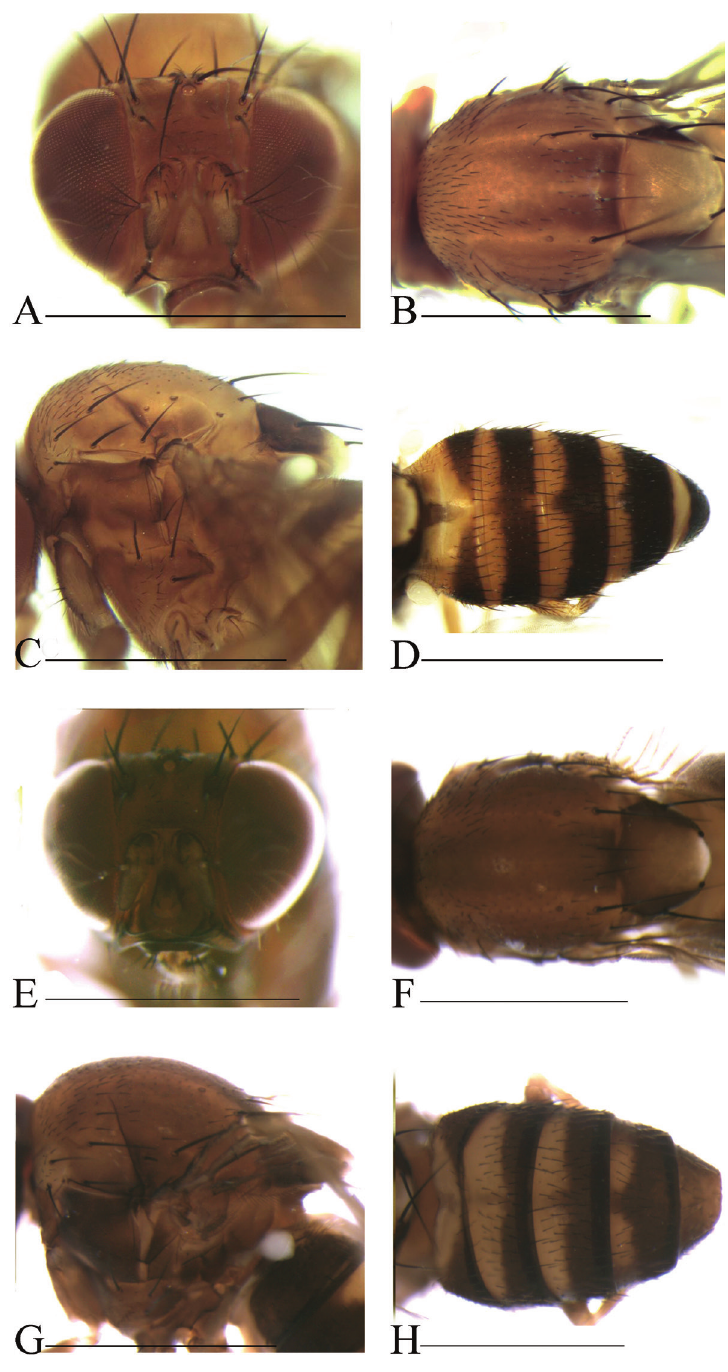
Figure 4. Head, mesonotum, scutellum, pleura and abdomen of male. A–D S. scutellimargo E–H S. maculata sp. n. Scale bars 1